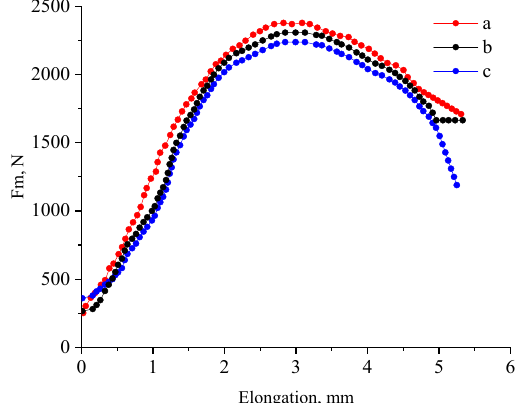
Figure 17. Stretching diagrams: (a) ABE wires treated by sequential immersion in tetraethoxysilane and ammonia (five cycles); (b) ABE wires treated by immersion in SiO 2 nanoparticles sol (five cycles); (c) uncoated wires (control sample).